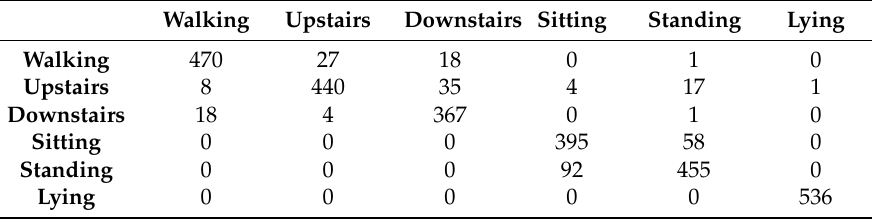
Table 9. Confusion matrix for hierarchical class dependent feature selection.